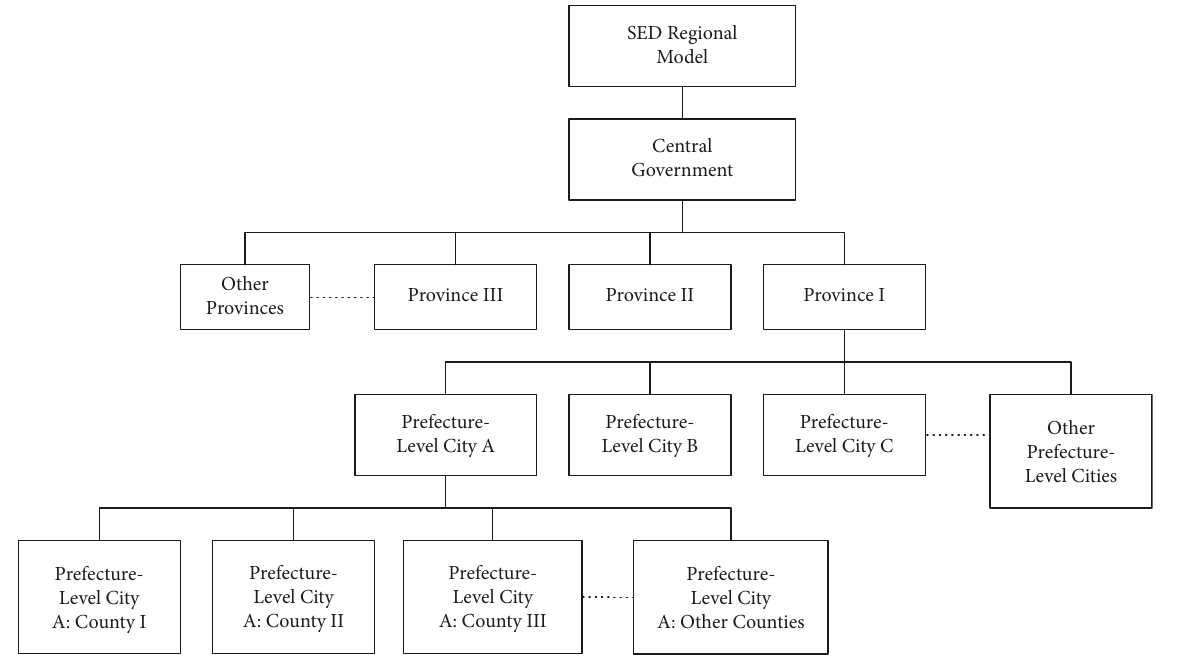
Figure 9: Multi-level structure of administrative regions (source: Guangzhou Milestone Software Co., Ltd.,